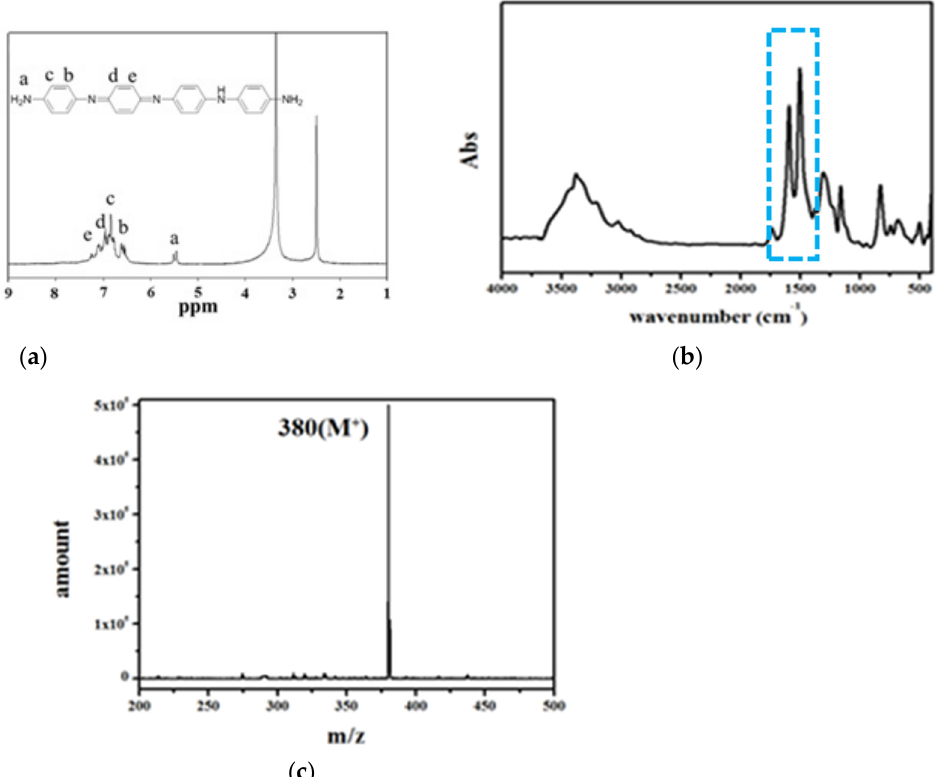
Figure 2. Characterization of ACAT as determined by ( a ) 1 H-NMR, ( b ) FTIR, and ( c ) mass spectroscopy.